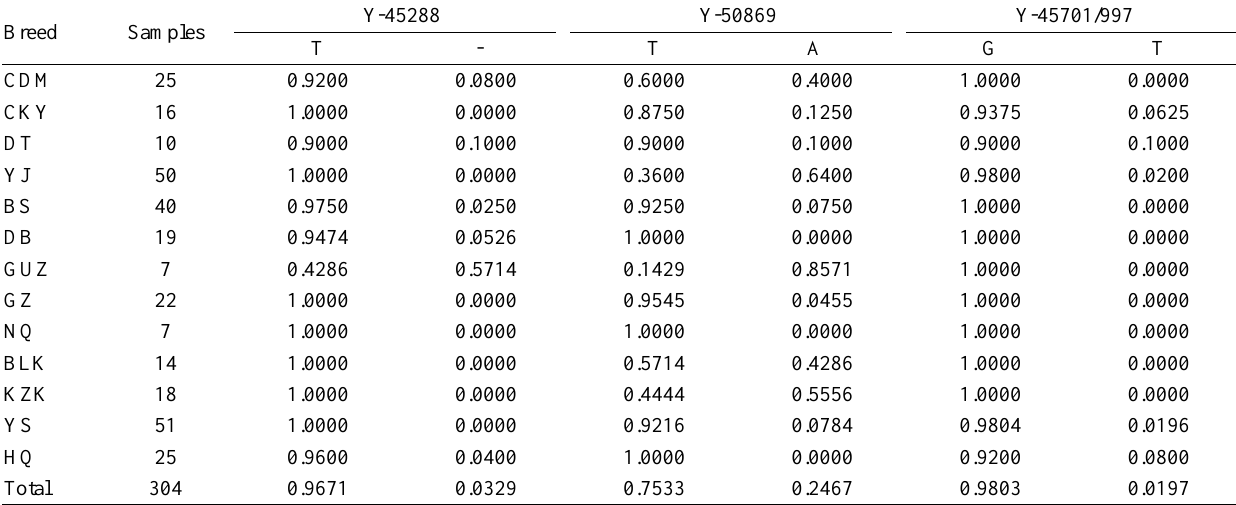
Table 3. Allele frequencies of three polymorphic loci in 13 horse breeds Breed Samples